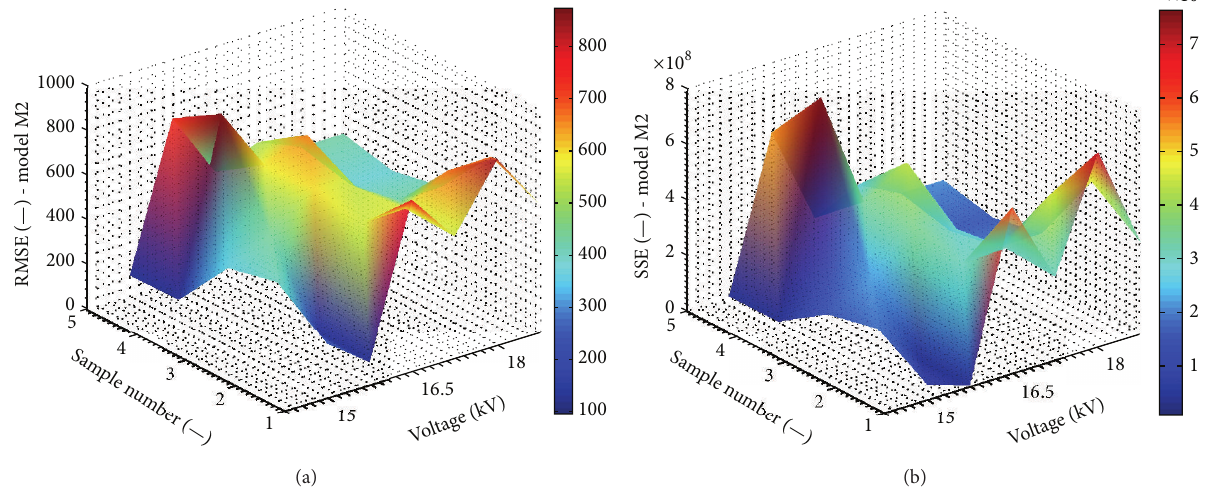
Figure 6: Comparison of values of coefficients RMSE (a) and SSE (b) obtained by the regression of the model M2 for all the recorded signals.